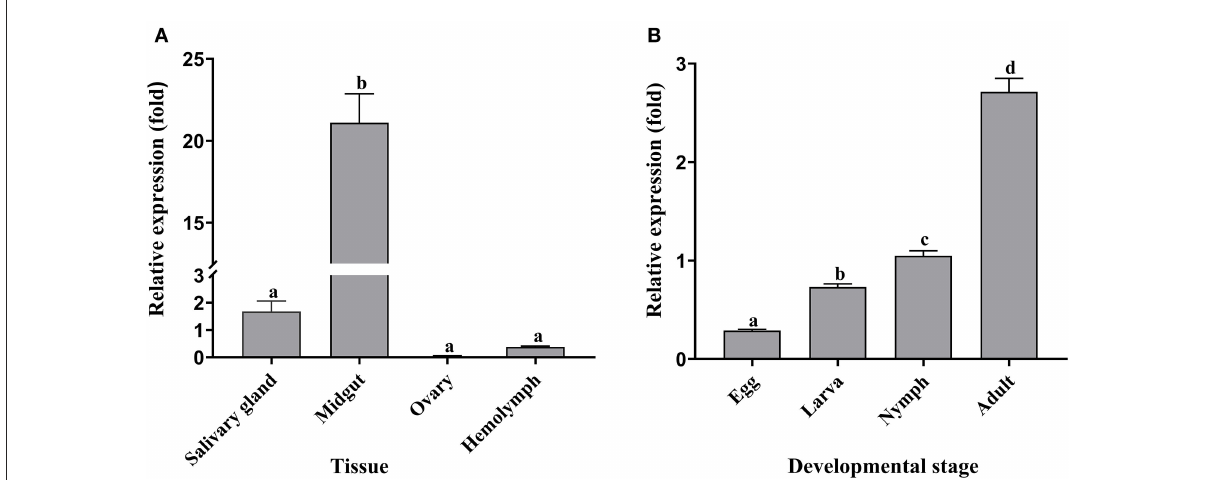
FIGURE3 Spatiotemporal expression level of Doenitin-1 in H. doenitzi . (A) Different tissues of Doenitin-1 . (B) Different stages of Doenitin-1 . The SPSS 16.0 software for Windows (SPSS Inc, IL, United States) was used to conduct a one-way ANOVA for qRT-PCR results. Different letters indicate statistical differences ( P < 0.05).